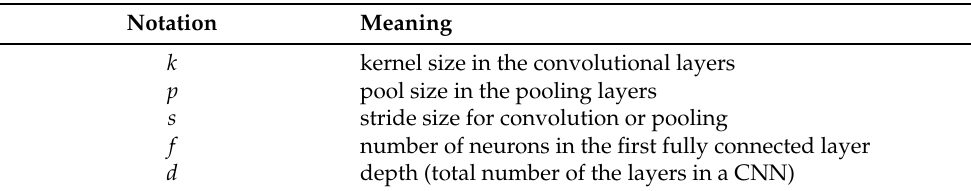
Table 3. Notations in the